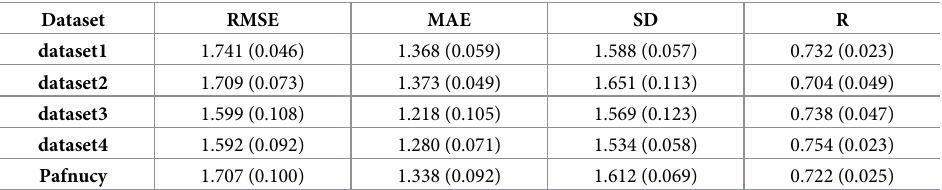
Table 5. The performance of GraphBAR with the CSAR NRC-HiQ set 1 (51 complexes).